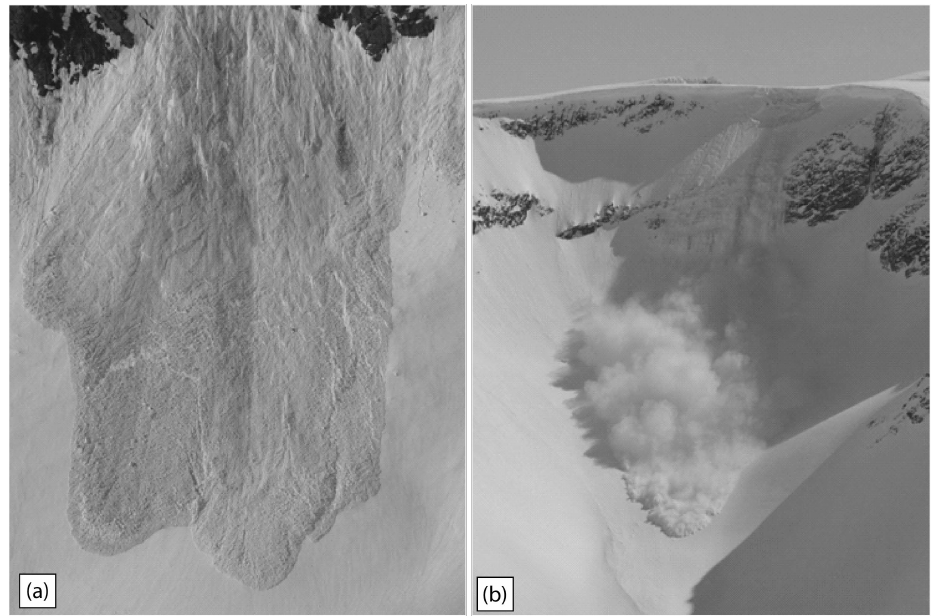
Fig. 1. Deposit of a naturally released snow avalanche (a) ; Artificially triggered avalanche in transit at NGI’s research station at Ryggfonn (b) . Both sites are located within the Strynefjell region, Sogn og Fjordane, Norway. Photos courtesy of: Krister Kristersen (a) and Hedda Breien (b) , Norwegian Geotechnical